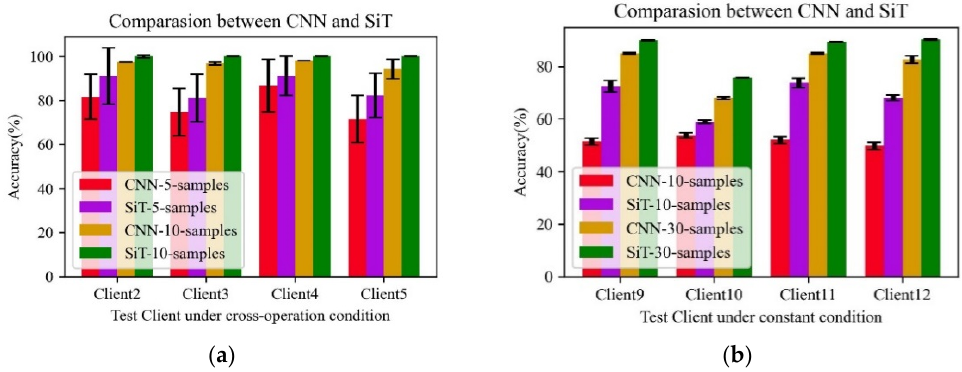
Figure 6. Performance of CNN and the constructed SiT. ( a ) The diagnosis results of SiT and CNN under constant operation conditions. ( b ) The diagnosis results of SiT and CNN under cross-opera- tion